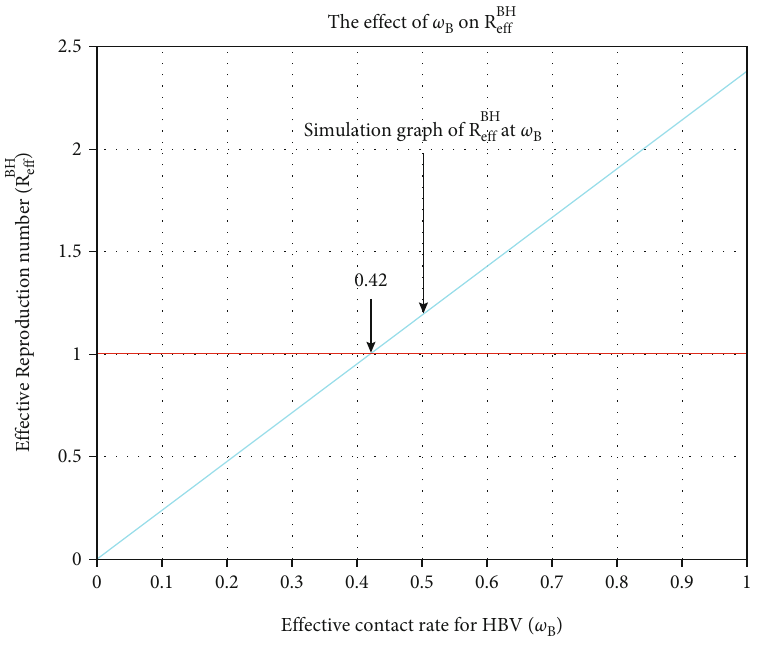
Figure 13: Simulation of the reproduction number of HBV-HIV/AIDS coinfection at variable contact rate ω